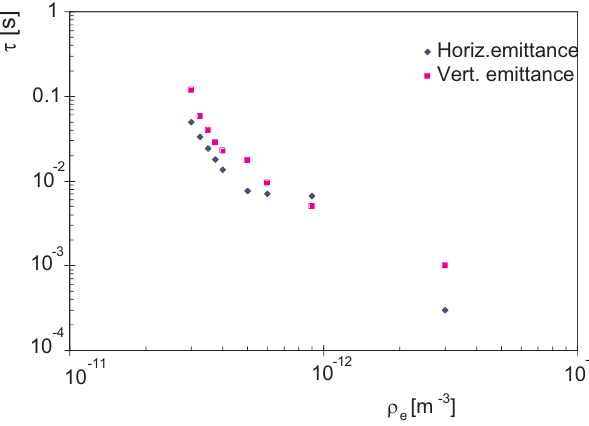
FIG. 8. (Color) Rise time (cid:8) as a function of the electron-cloud density; the rise time (cid:8) is defined as the time corresponding to an emittance increase from 7 : 82 (cid:6) 10 (cid:4) 9 m (initial value) to 8 (cid:6) 10 (cid:4) 9 m ( (cid:5) 2 : 3% ), at Q 0 (cid:2) 2 .